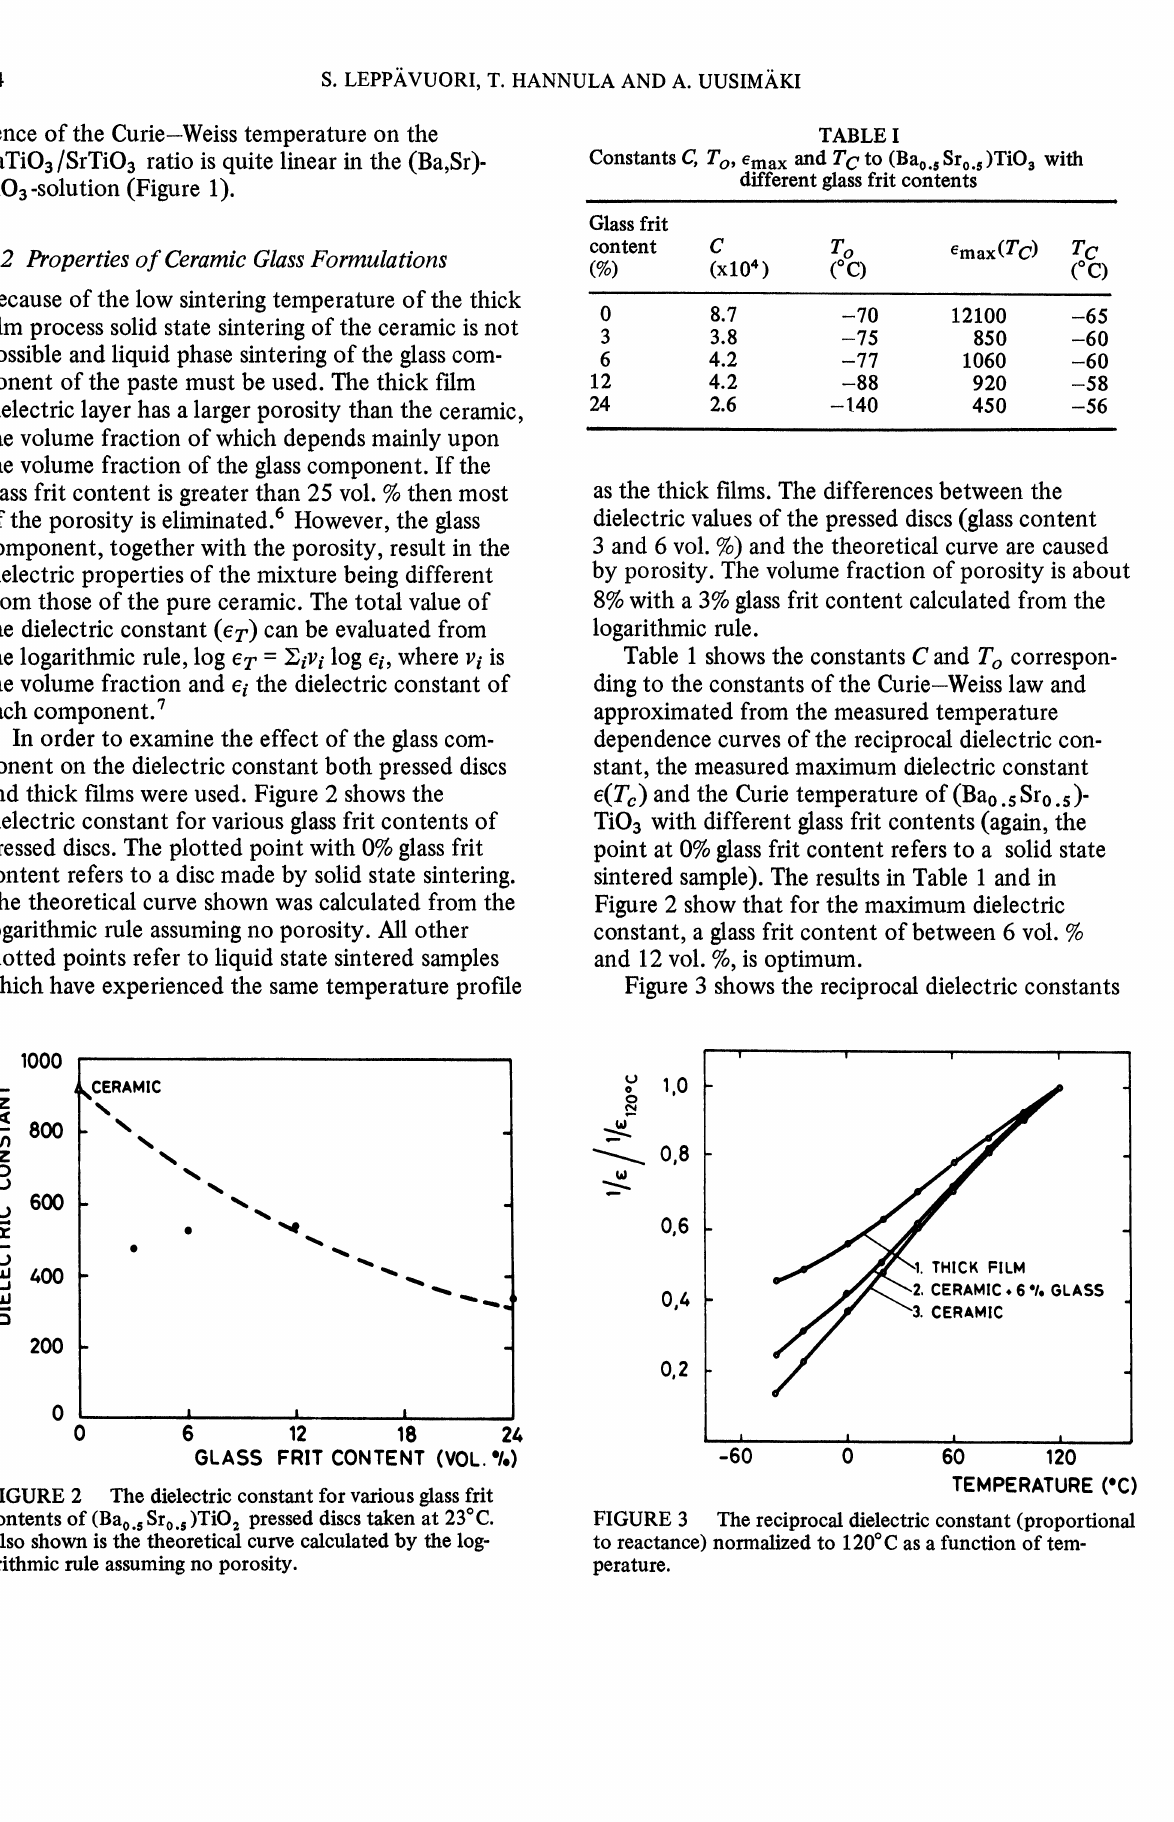
The dielectric constant for various glass frit contents of (Ba0. St0. )TiO pressed discs taken at 23 C. Also shown is the theoretical curve calculated by the log- arithmic rule assuming no porosity.